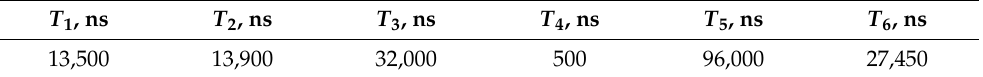
Table 1. The time cost for executing a 32-bit module authentication protocol. T 1 , ns T 2 ,